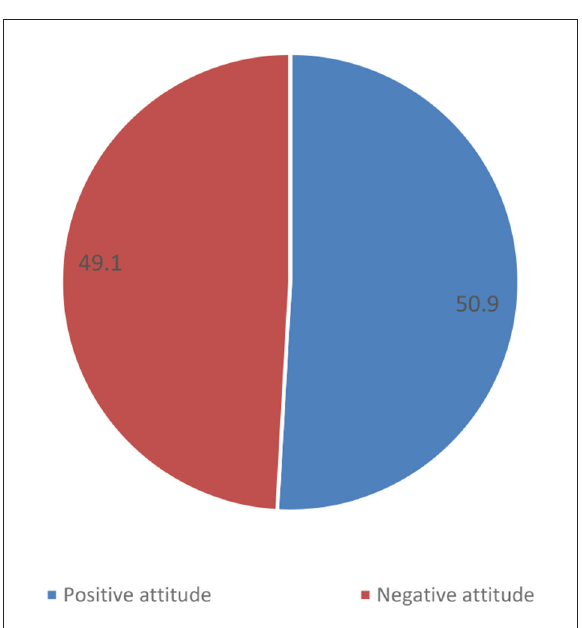
FIGURE2 Attitude of the physicians regarding the COVID-19 vaccine. Shows the distribution of HCPs’ status toward COVID-19 vaccine with regards to “Positive” and “Negative”